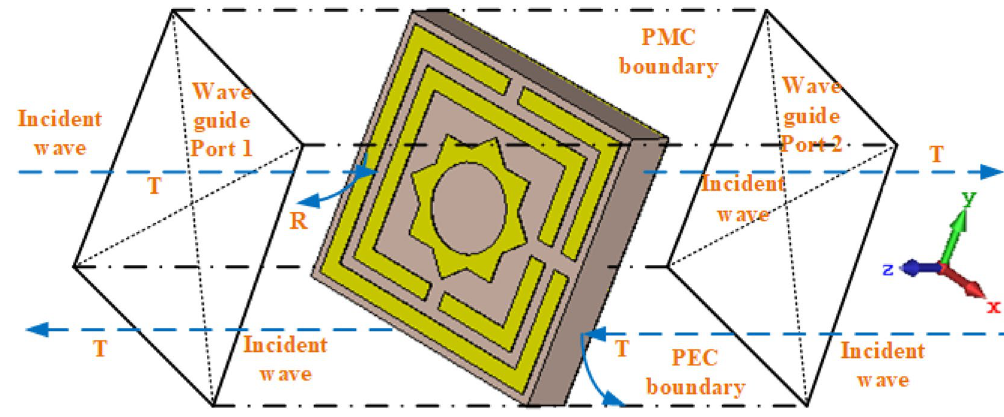
Figure 2. Boundary condition on MAA.